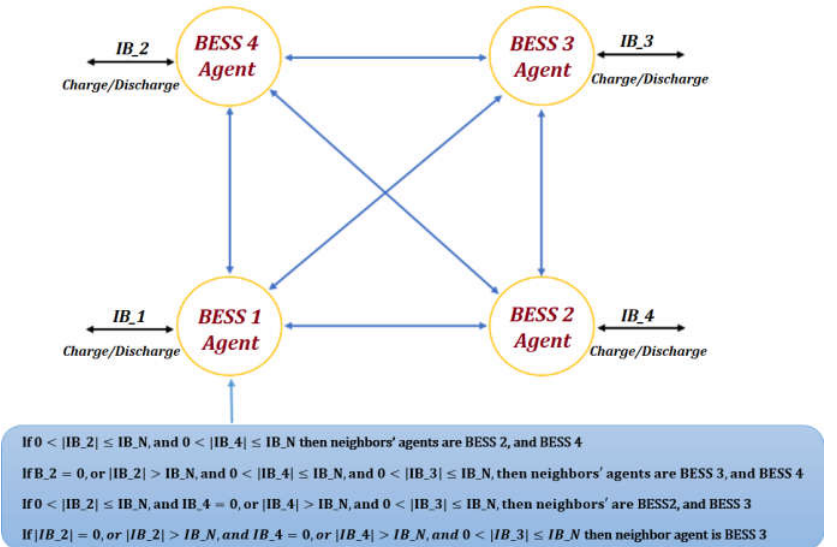
Figure 11. Multiagent communication topology of the adapted primary–secondary control with the plug-and play clarification, and neighbors coordination scenarios.